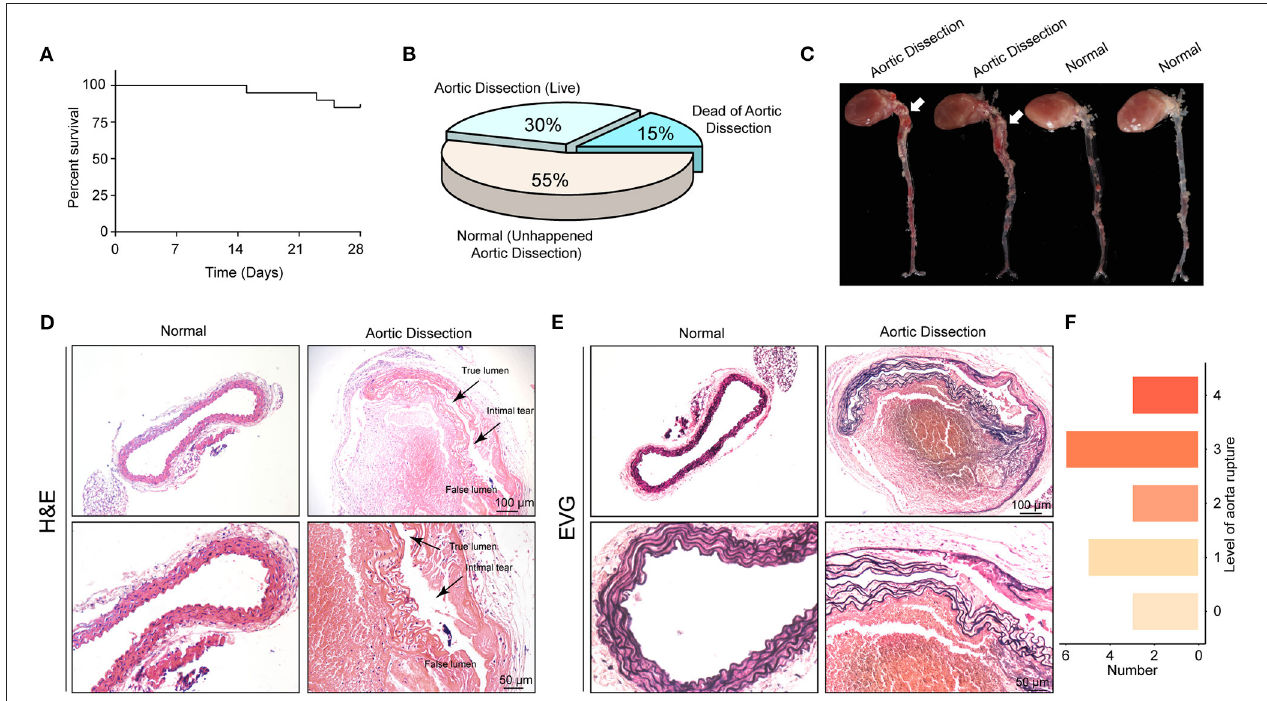
FIGURE 6 | The AD model was successfully established with young mice by administering BAPN. (A) Survival curves of the male mice treated with 0.6% β -aminopropionitrile (BAPN) when 3 weeks old. (B) The overall incidences of indicated conditions in mice after 4 weeks of BAPN treatment. (C) Representative macroscopic images of excised aortas after 4 weeks of BAPN treatment. (D,E) Representative images of H&E-stained (D) and EVG-stained (E) aorta sections from non-AD and dissected mouse aortae. The true/false lumens and intimal tears were labeled in the dissected aorta. (F) Distribution of the degree of elastin rupture in mice treated with BAPN treatment. n =